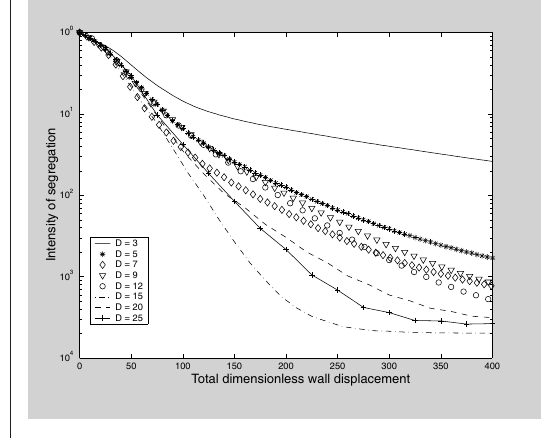
Figure 9: Comparison of different dimensionless wall-displacements for the four-step mixing